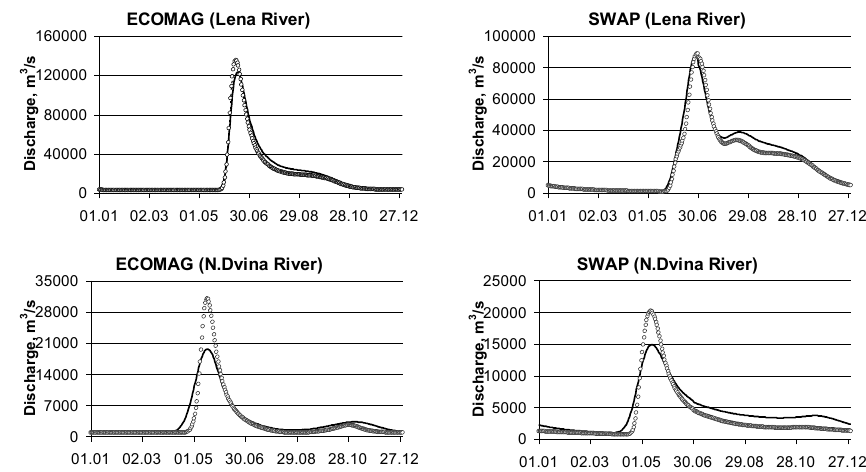
Figure 5. Mean hydrographs calculated as an averaged response to ensemble input (solid line) and as a response to ensemble averaged input (dotted line).